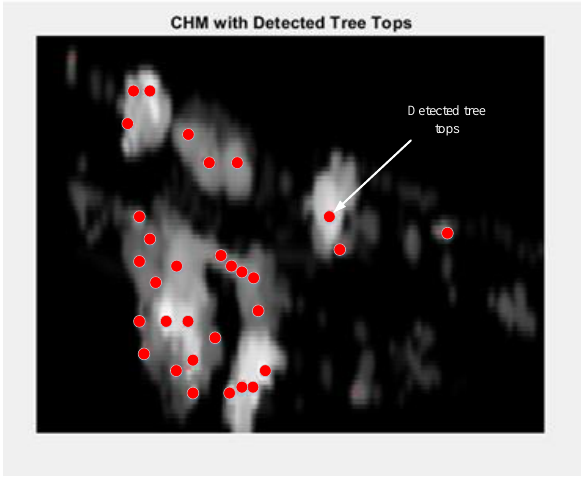
Figure 9 . The view of CHM with detected tree tops.